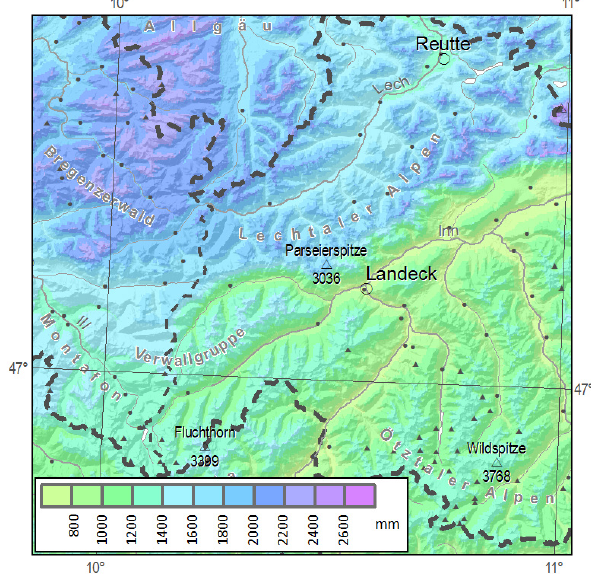
Figure 3. Map example 2. Mean annual precipitation sum, map section for a part of Western